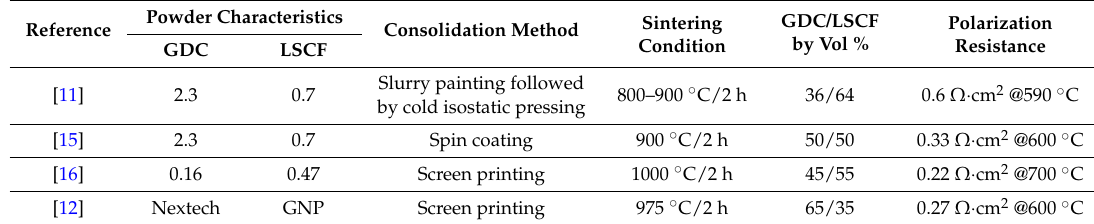
Table 1. Summary of key processing parameters used by several research groups to determine the optimum composition of GDC/LSCF composite